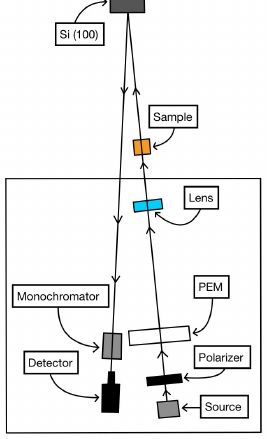
Figure 3. Sketch of the CD-RAS experimental spectrometer. The version here reported is the Safarov/Berkovits-like (see Refs. [1–3,29]), with one polarizer. After passing the sample, the light beam is reflected back by an isotropic Si(100) sample. Although the system was mounted horizontally in this case, it can also work vertically.